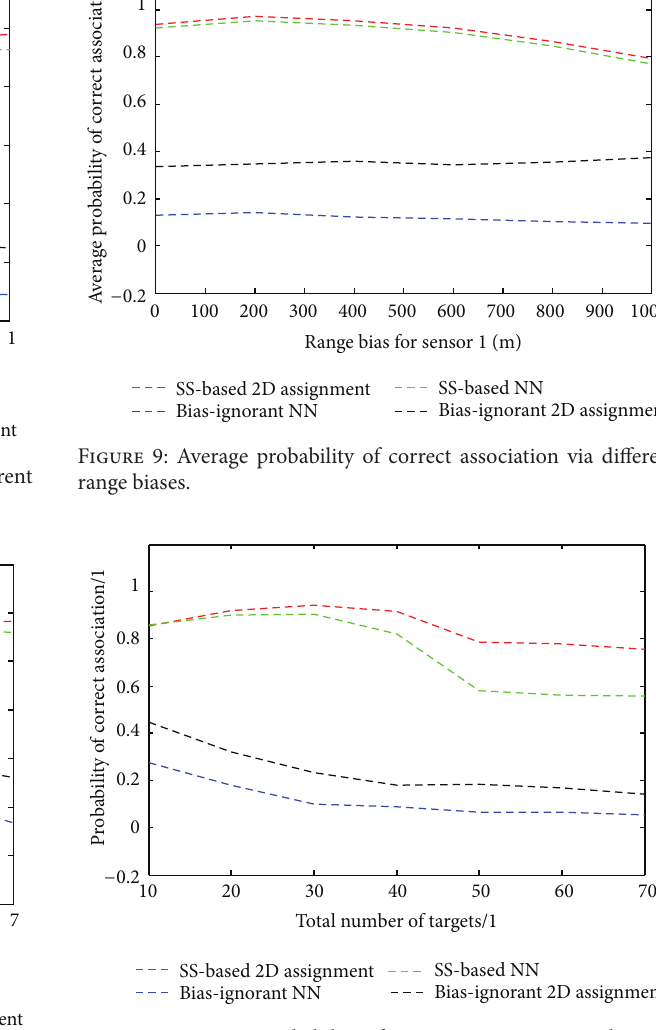
Figure 10: Average probability of correct association via the total number of